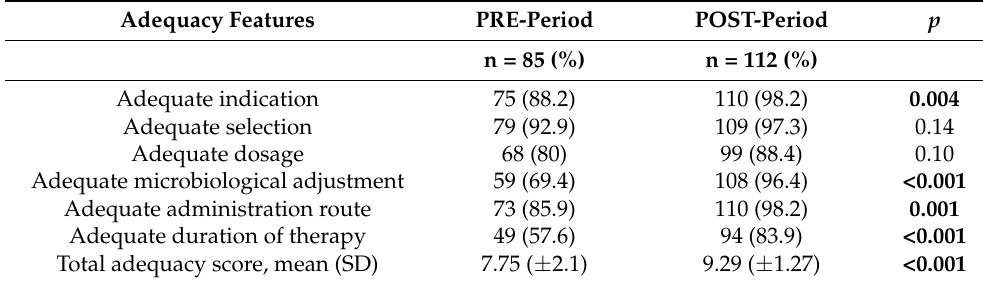
Table 5. Evaluation of antifungal